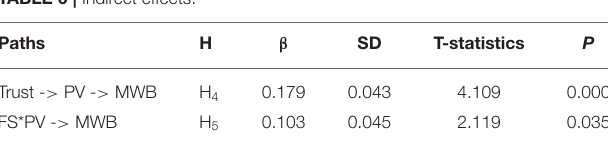
TABLE 6 | Indirect